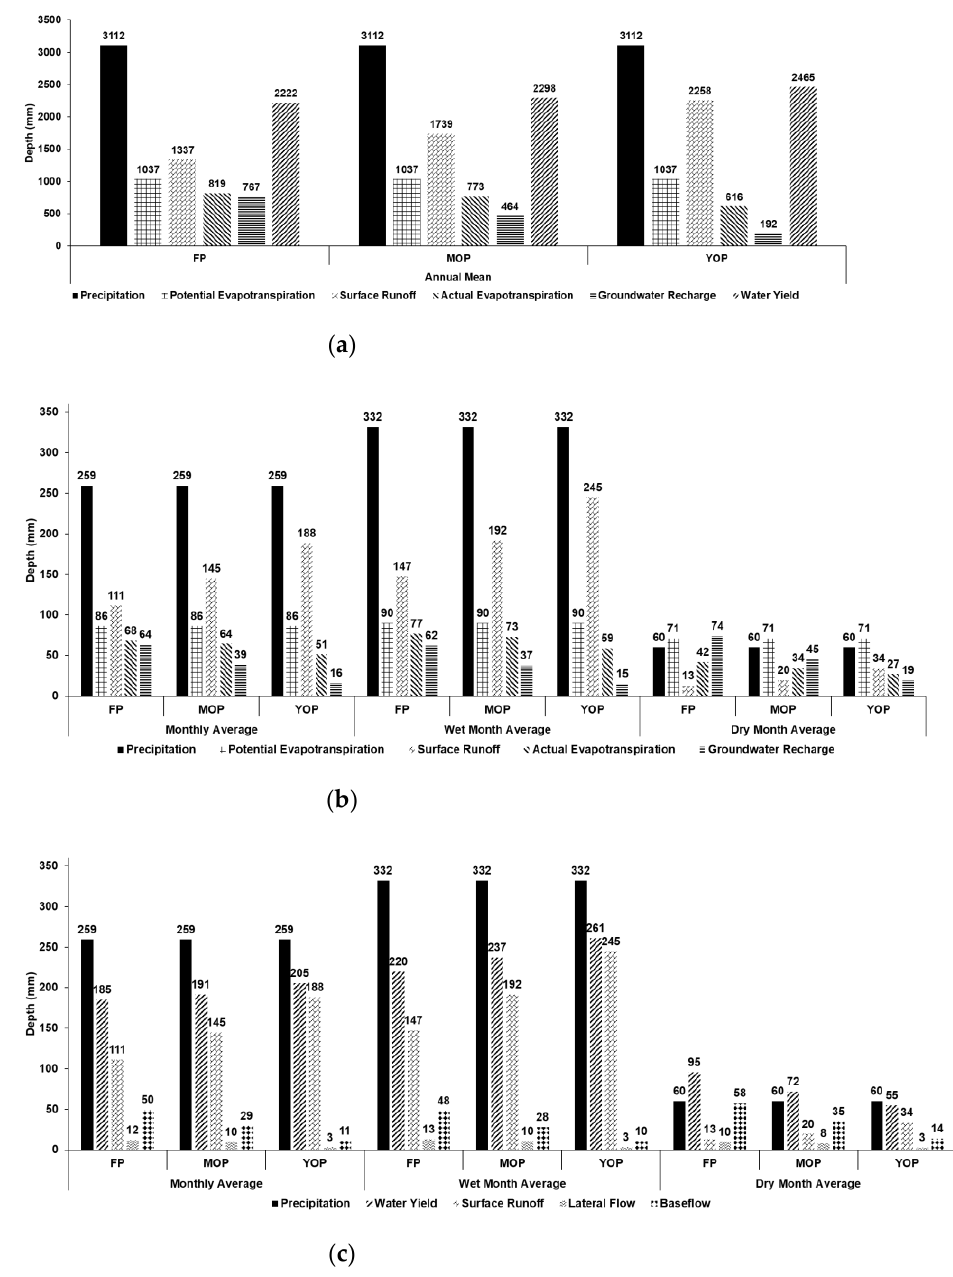
Figure 5. Annual ( a ) and seasonal mean of water regulation ecosystem services ( b ) and water yield ( c ) elements.